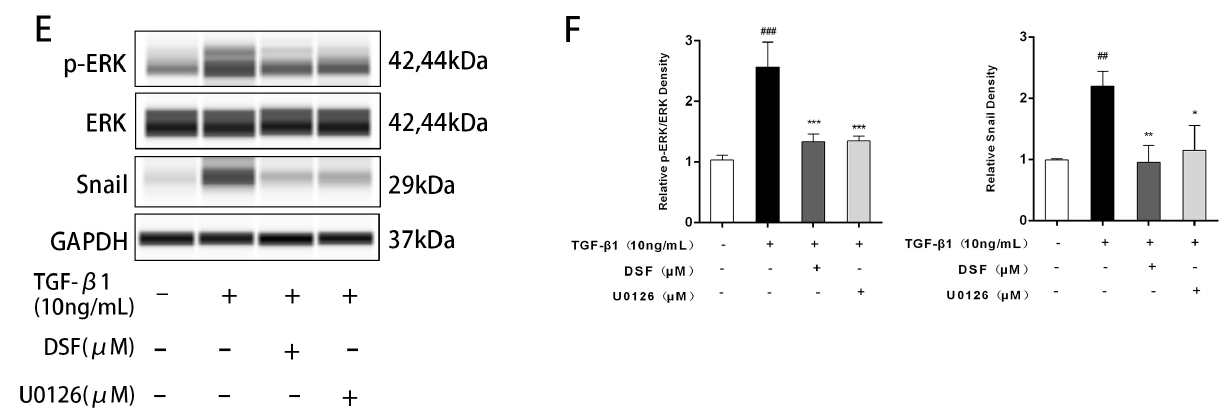
Figure 3. DSF regulates the ERK-Snail pathway during fibrosis. ( A ) Cell lysates were subjected to Western blotting, and p-Smad2, Smad2, p-Smad3, Smad3, p-ERK, ERK, and Snail expression were assessed. ( B ) Protein expression levels of p-Smad2/Smad2, p-Smad3/Smad3, p-ERK/ERK, and Snail were quantified by densitometry and normalized to the GAPDH level for each sample, n = 3. ( C ) The protein expression levels after treatment with TGF- β 1 (10 ng/mL)/DSF (4 µ M)/U0126 (10 µ M). ( E ) p-ERK, ERK, and Snail expression were assessed by Western blotting. ( D , F ) The protein levels were quantified, analyzed, and normalized to the level of GAPDH for each sample, n = 3. The data are expressed as the triplicates’ mean ± standard deviation (SD). ## p < 0.01, ### p < 0.001, and #### p <0.0001 compared with the control; * p < 0.05, ** p < 0.01, and *** p < 0.001, compared with TGF- β 1 alone; ns denotes no statistical significance versus TGF- β 1